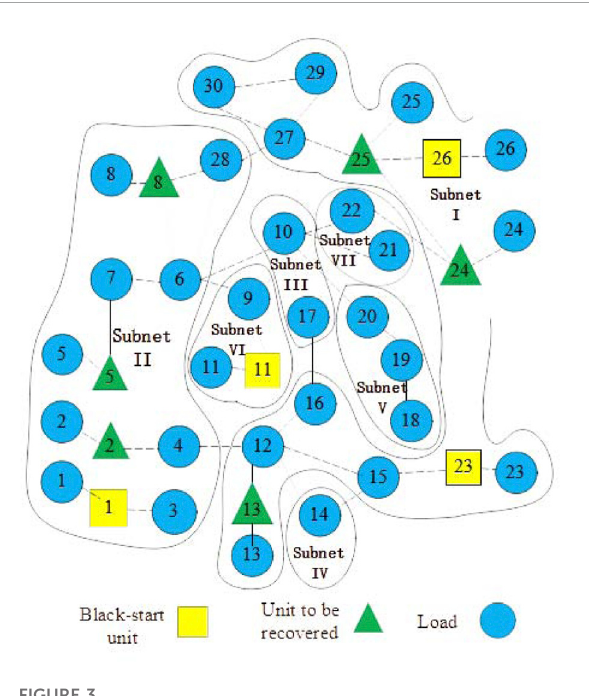
FIGURE 3 Post-disaster line cracking